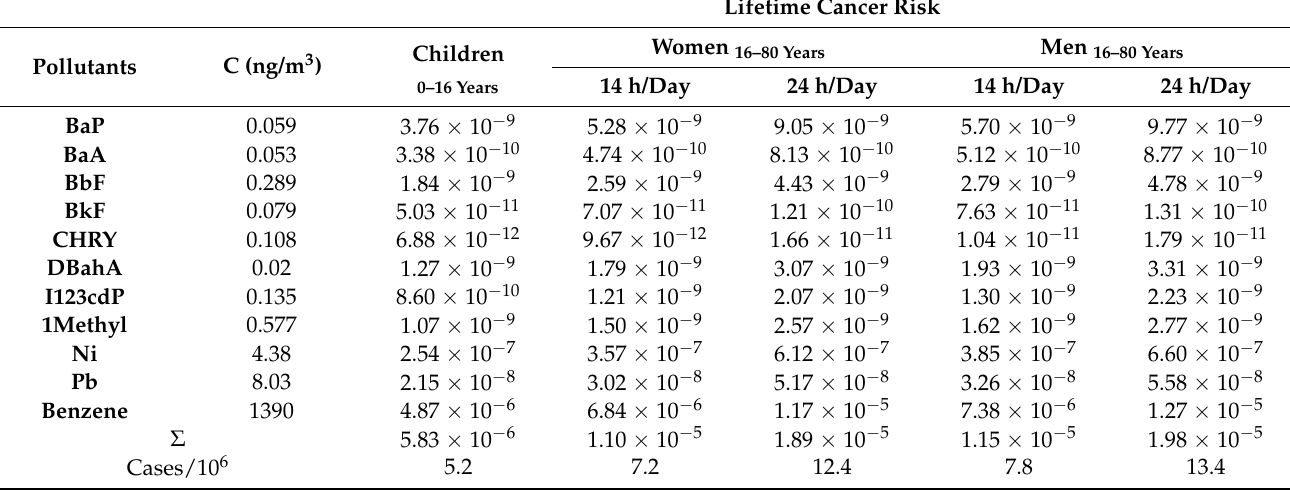
Table A3. Cancer risk assessment A.III method (Jackson,